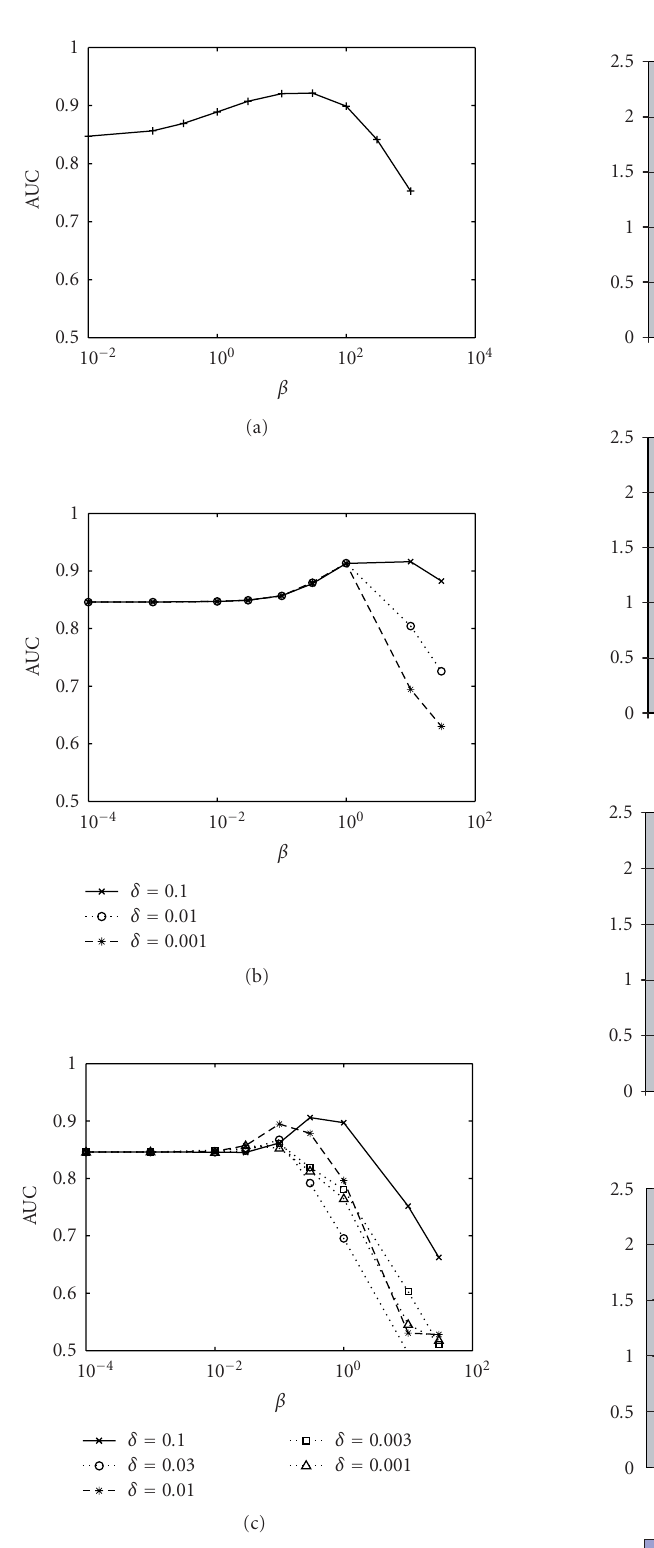
Figure 6: Plots of AUCs for detecting the 15-mm lesion in the lumpy background shown in Figure 3(c) as a function of the prior parameters: (a) Gaussian prior; (b) Huber prior; and (c) Geman- McClure prior.